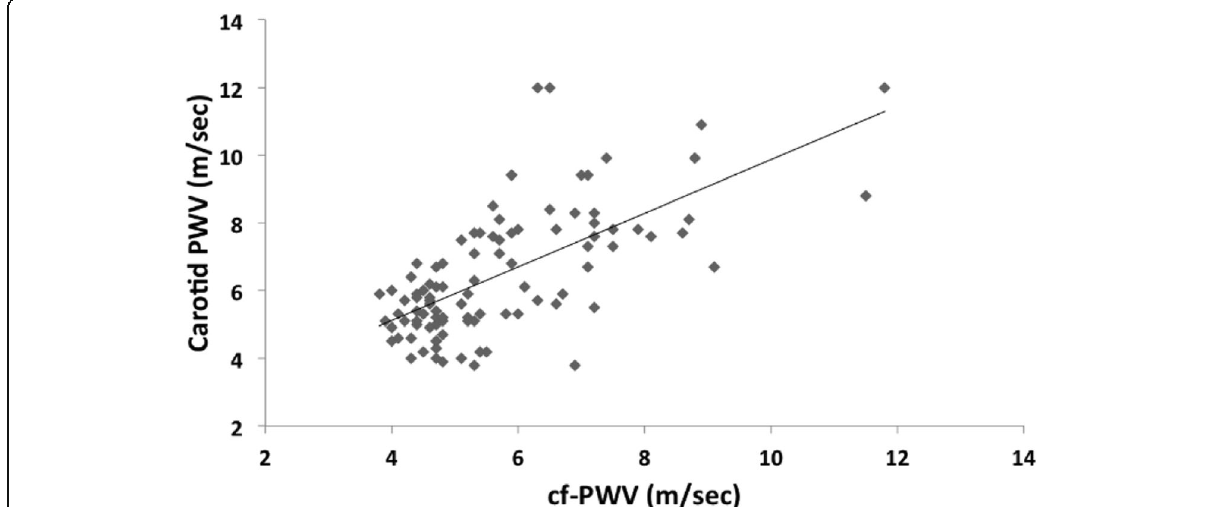
Fig. 3 Correlation between cf-PWV and carotid PWV in SLE patients and controls